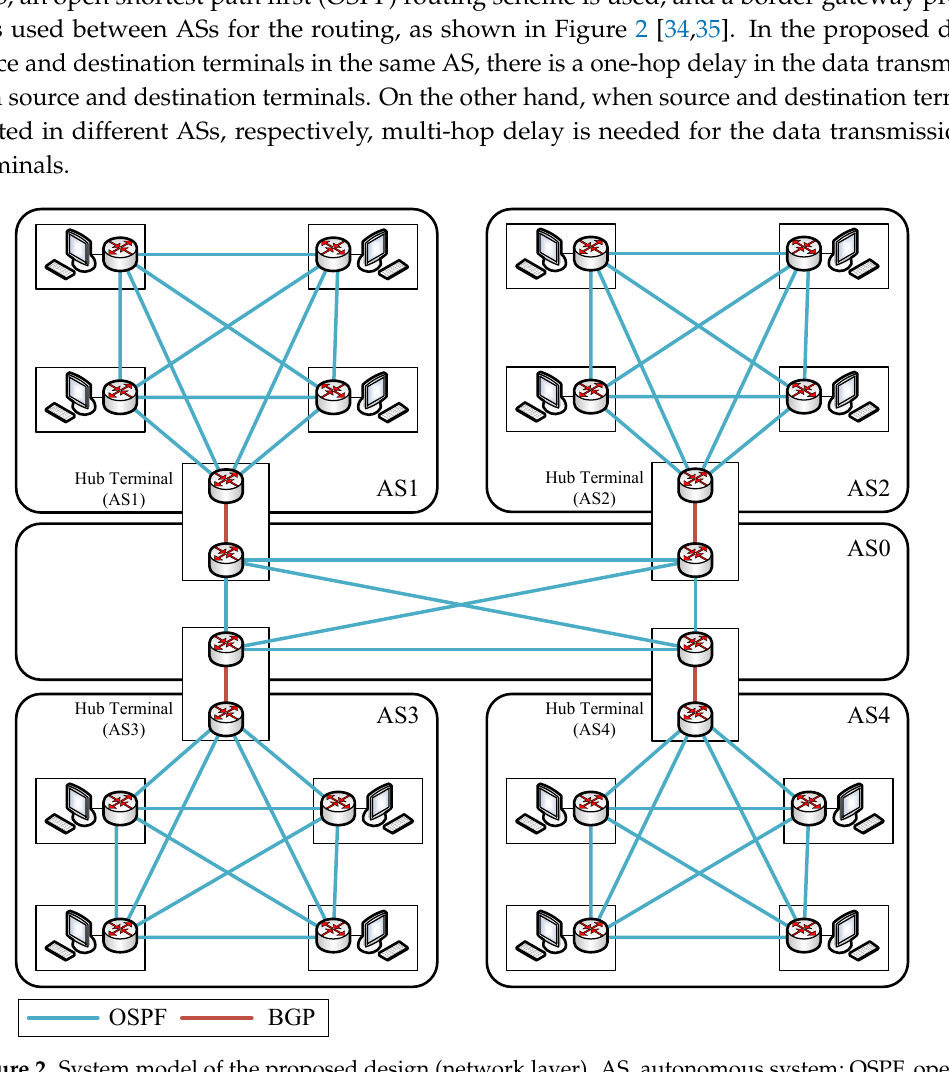
Figure 2. System model of the proposed design (network layer). AS, autonomous system; OSPF, open shortest path first; BGP, border gateway